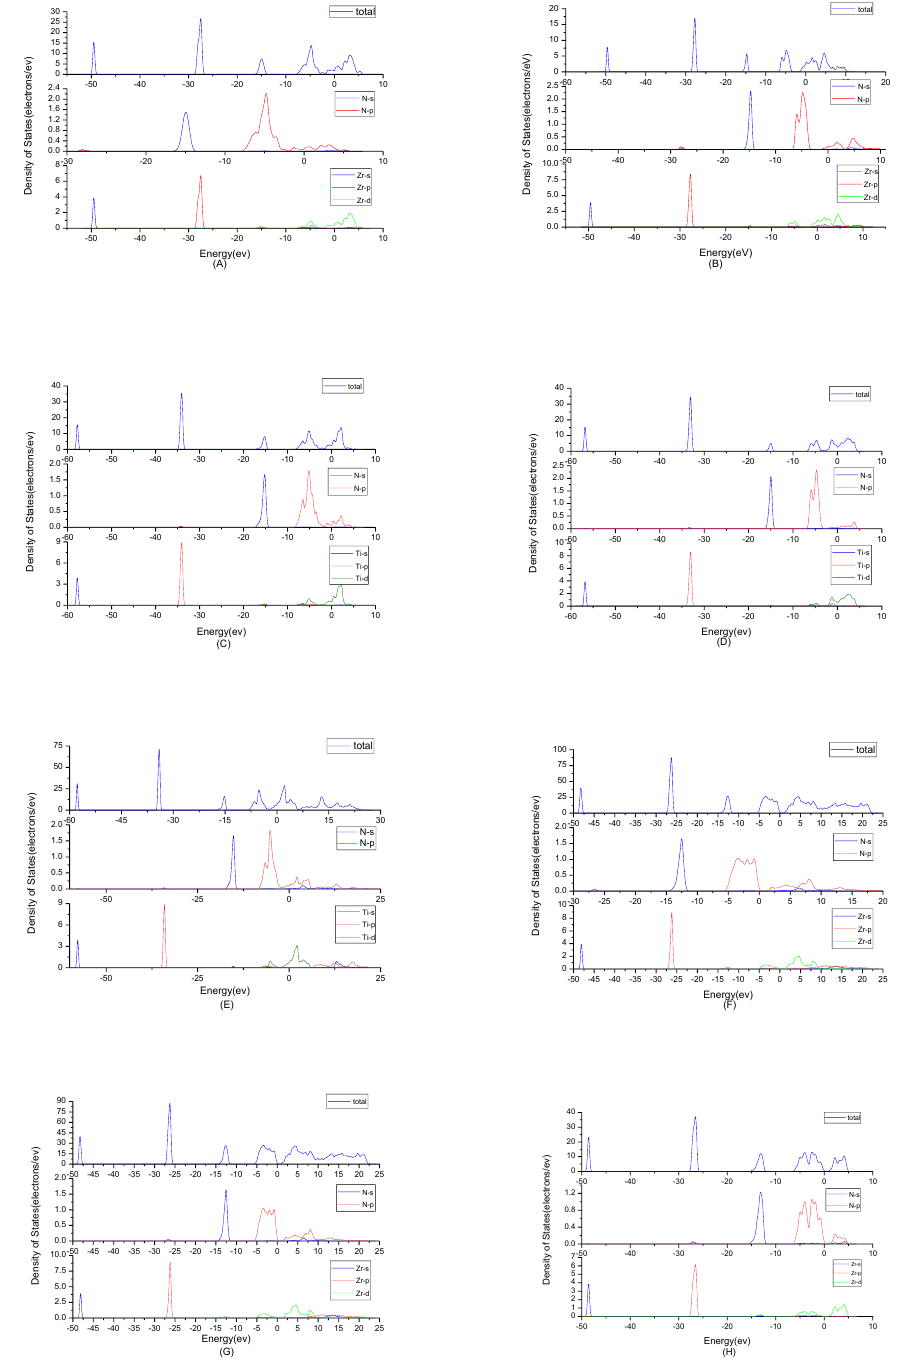
Figure 3. Total density of states plots and partial density of states plots of ( A ) ZrN with space group Fm3m; ( B ) ZrN with space group P6 3 mc; ( C ) TiN, ( D ) Ti 2 N with space group P4 2 /mnm; ( E ) Ti 2 N with space group I4 1 /amdz; ( F ) Zr 3 N 4 with space group Pna2 1 ; ( G ) Zr 3 N 4 with space group Pnam; ( H ) Zr 3 N 4 with space group